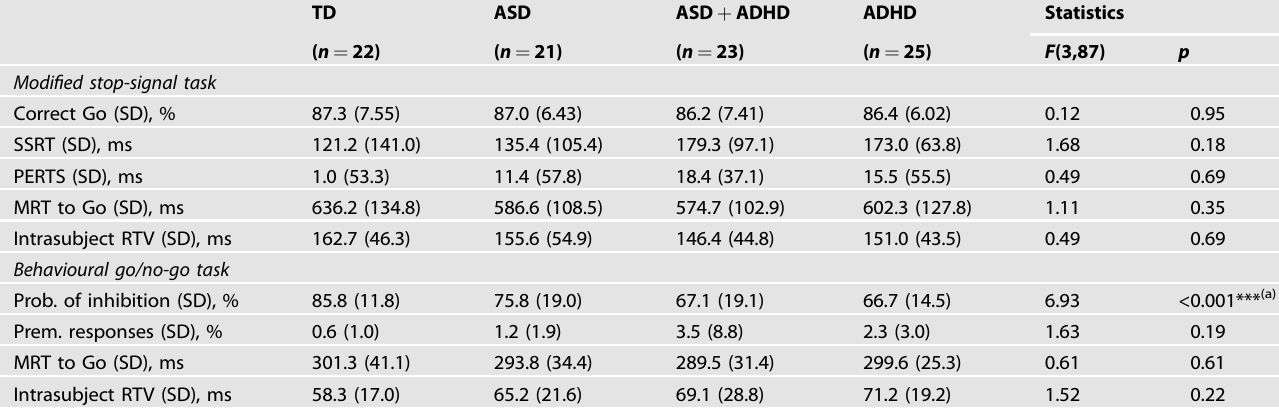
Table 2. Behavioural task performance.